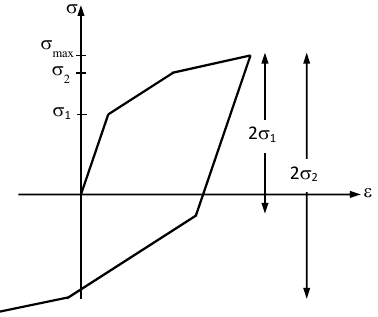
Fig. 5. Stress-Strain behavior of multilinear kinematic hardening model for Bauschinger Fig. 5. Stress-strain behavior of multilinear kinematic hardening effect. model for Bauschinger effect.